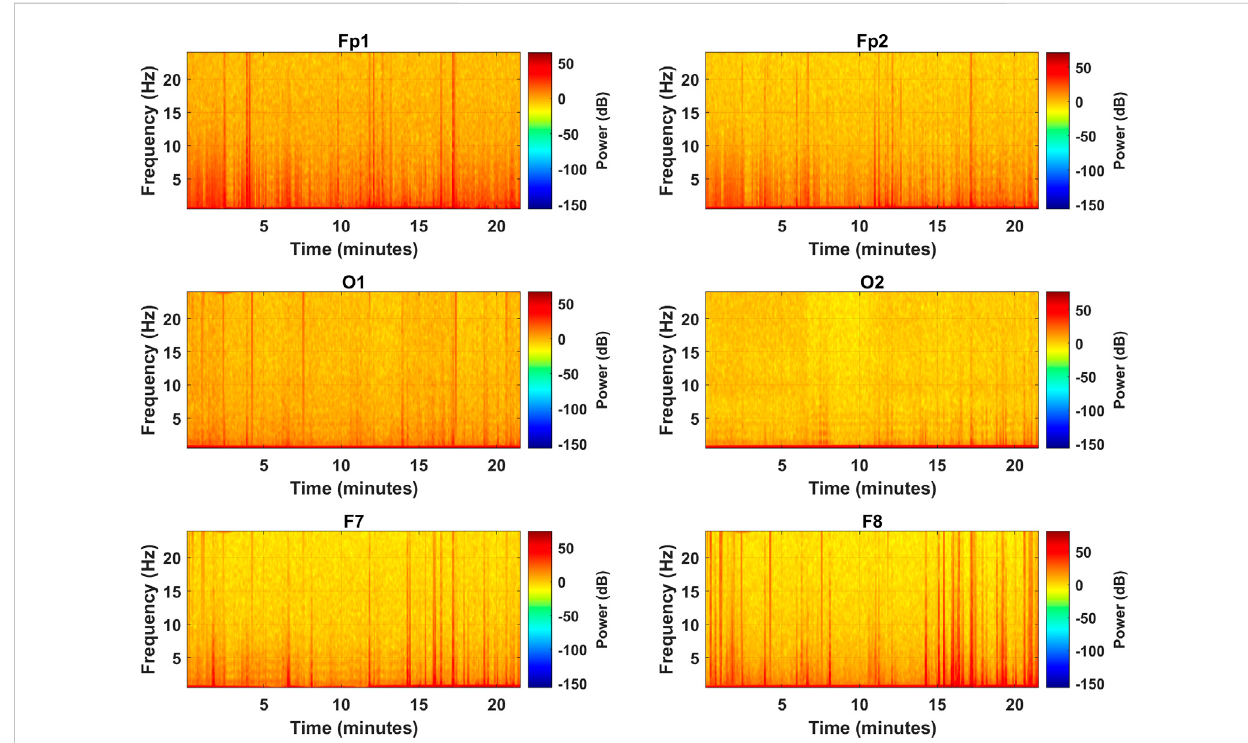
FIGURE 6 Spectrograms for the complete experiment over the frequency range of all EEG bands for the selected channels (subject